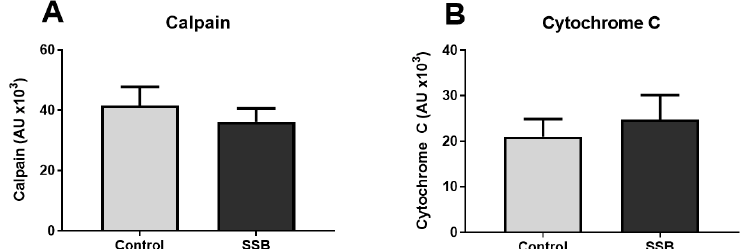
Figure 4. The effect of SSB consumption on calpain and cytochrome c expression. ( A ) Calpain and ( B ) cytochrome c levels. Data are displayed as mean ± SEM ( n = 8).